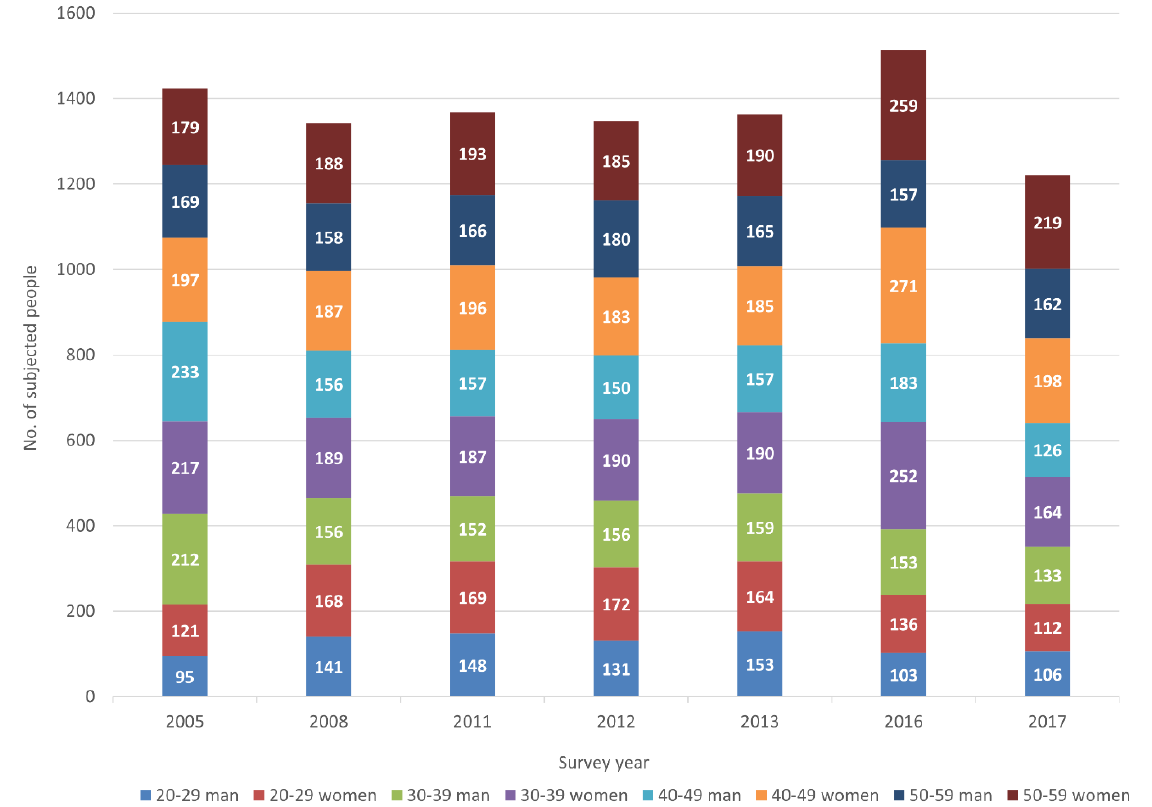
Figure 1. Numbers of subjects with blood Cd concentrations and dietary intake data from the 2005 to 2017 surveys.